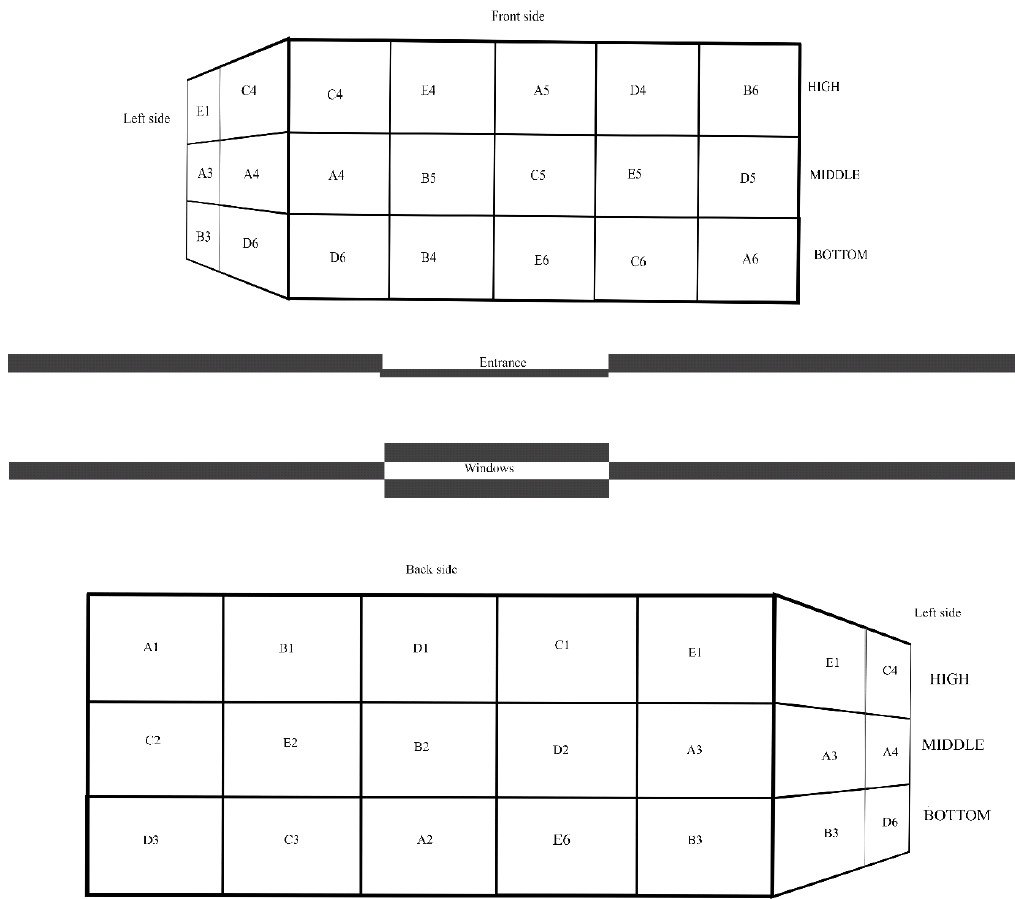
Figure 1. Diagram presenting arrangement of individual digestibility